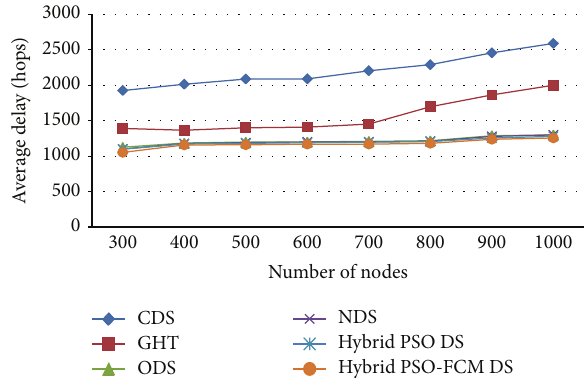
Figure 7: Average delay